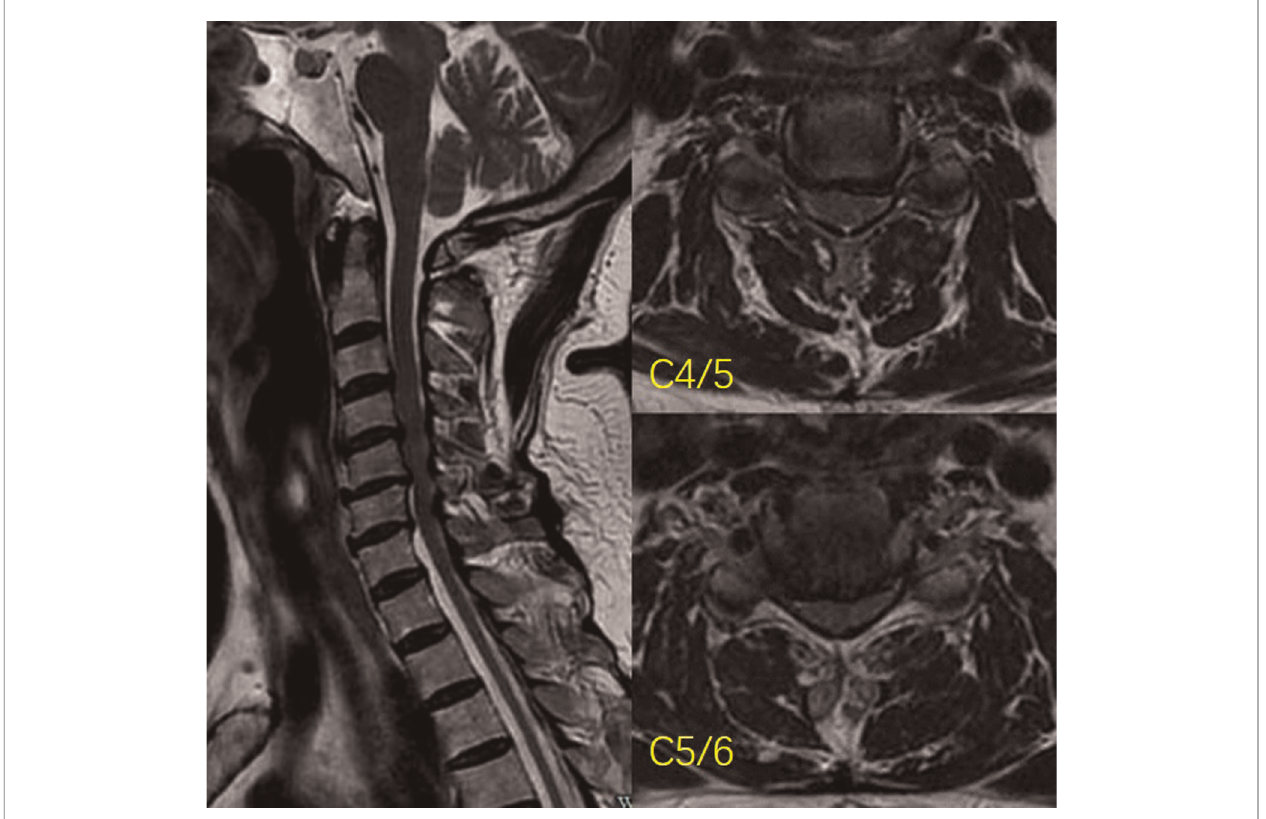
FIGURE 1 | Preoperative MR images show central canal stenosis at the C4-C6. The spinal cord was compressed by herniated discs and a hypertrophied ligamentum fl